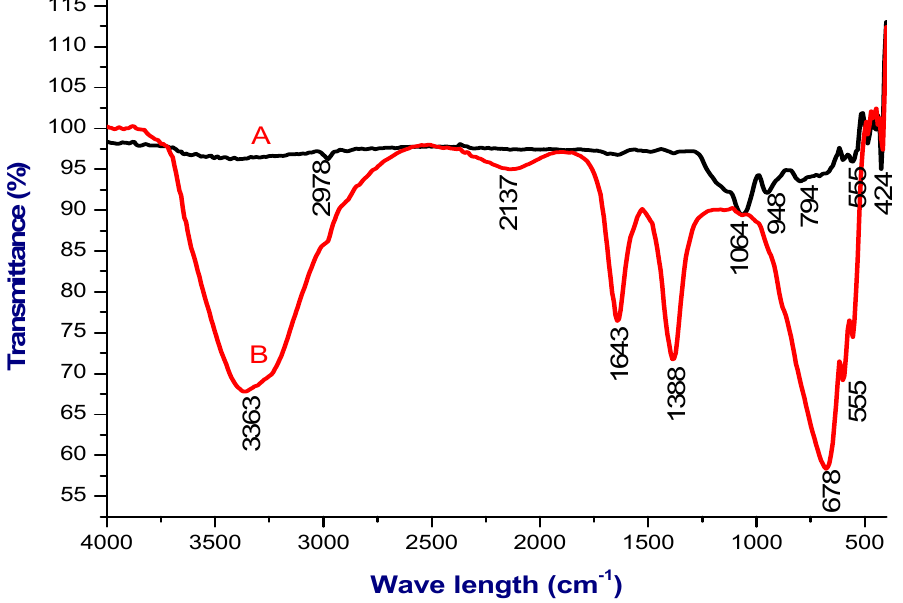
Figure 2. FTIR spectra, where A = n Si and B = extracted lignin from coir pith. (Metal oxide group of the n Si was observed.)